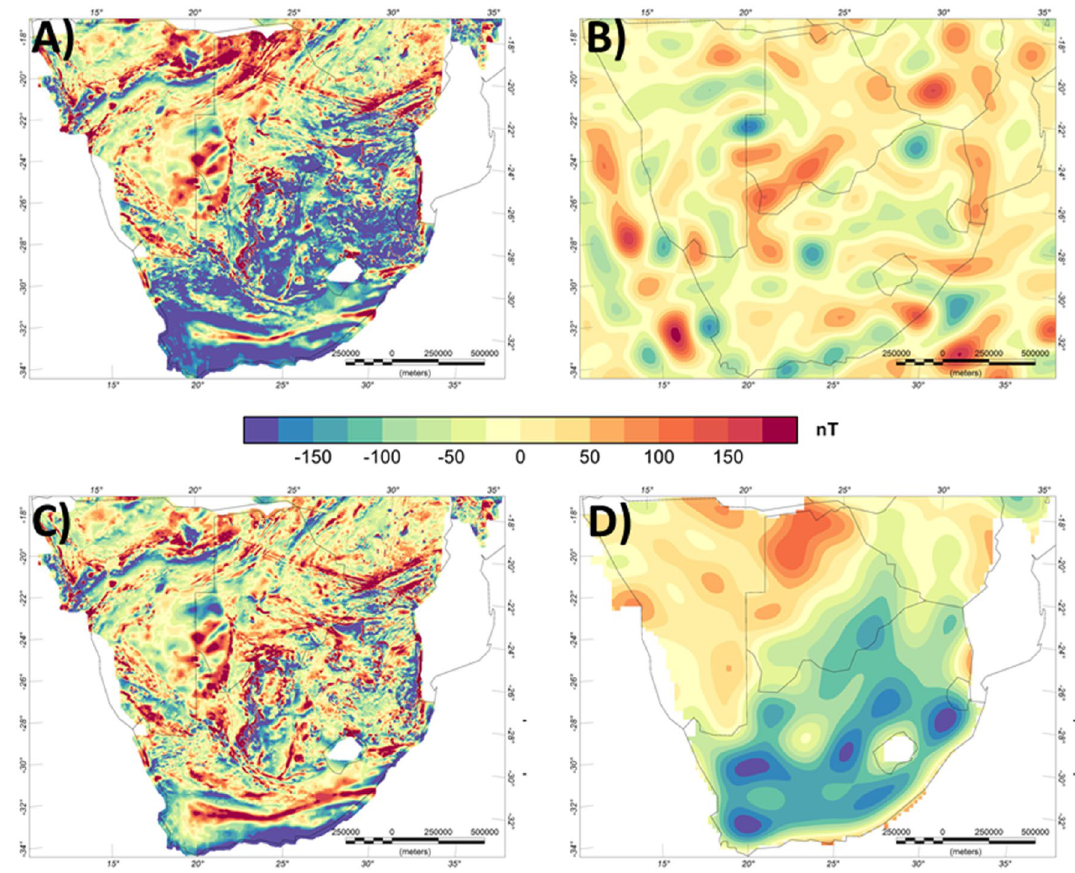
Figure 2. Lithospheric magnetic anomaly of Southern Africa. ( A ) Original aeromagnetic compilation 29 , ( B ) Satellite-derived model LCS-1, ( C ) Conformed aeromagnetic and satellite model. ( D ) Difference of ( A , C